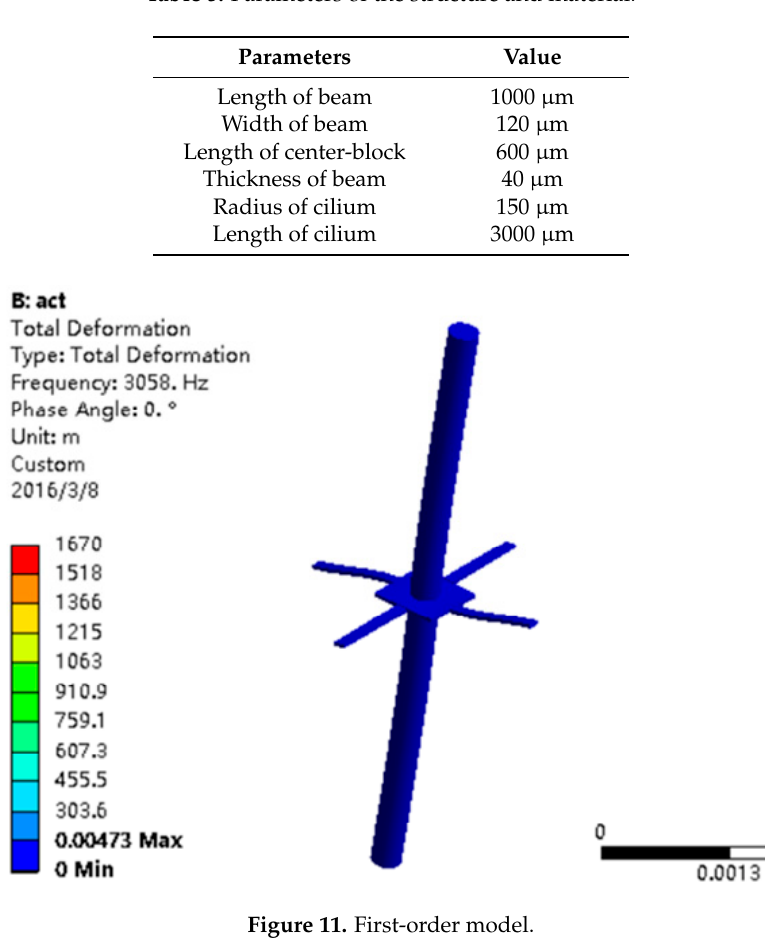
Table 5. Parameters of the structure and material.